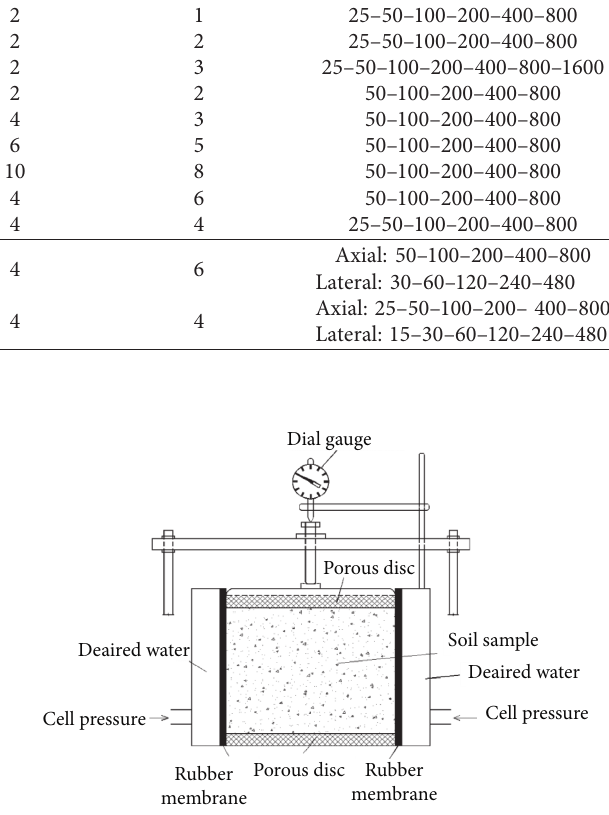
Figure 3: The improved apparatus for geometric confined con- solidation